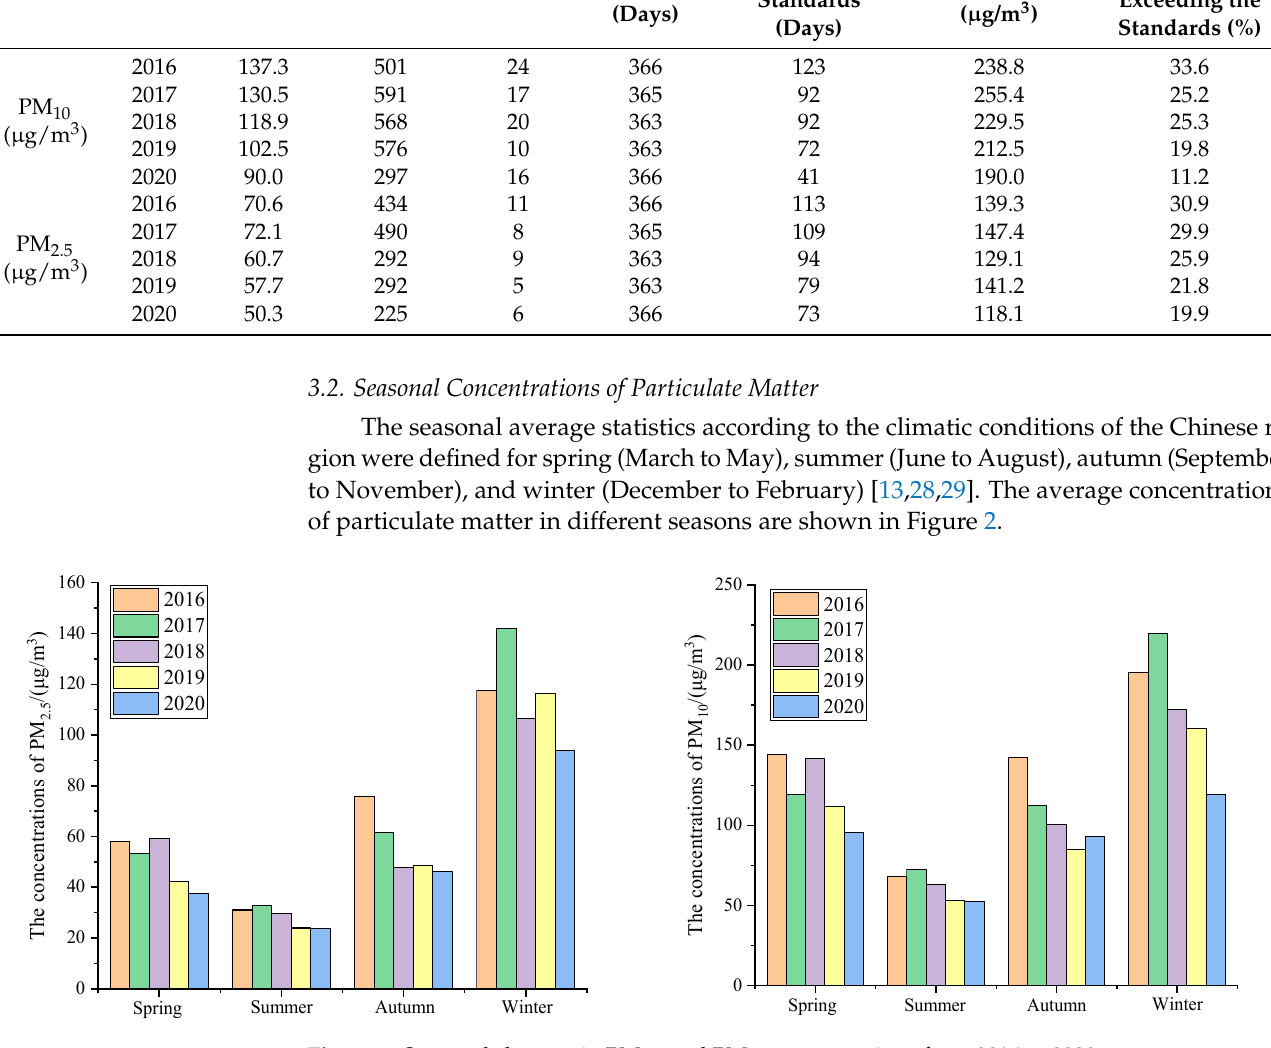
Figure 2. Seasonal changes in PM 2.5 and PM 10 concentrations from 2016 to 2020.